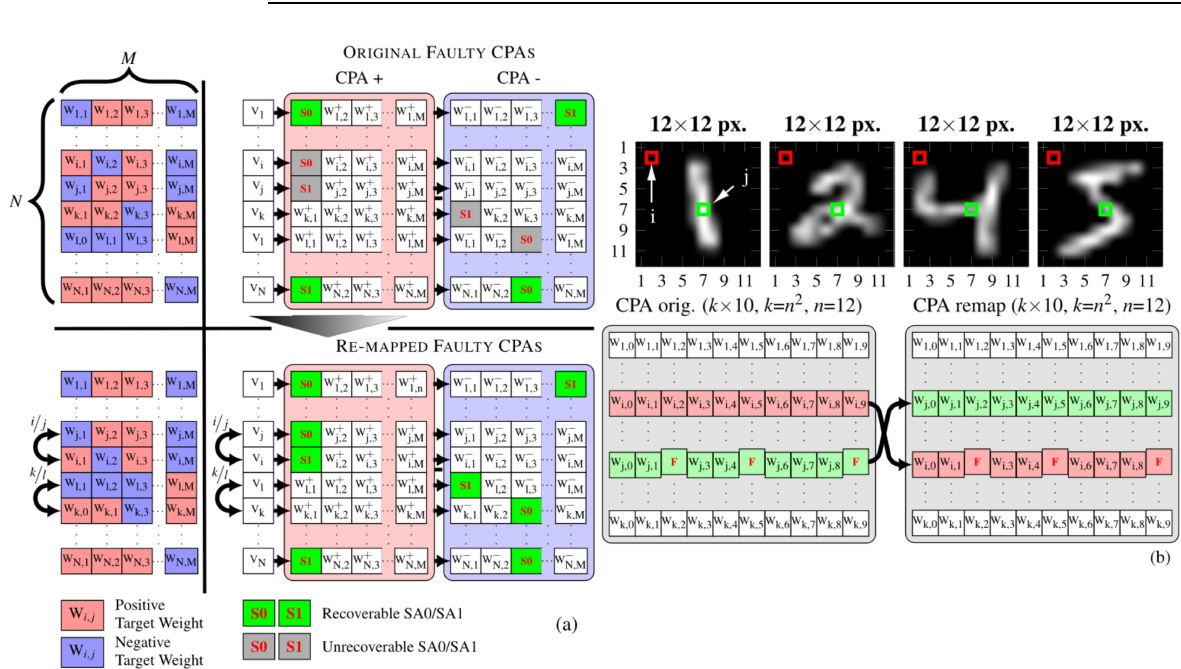
Figure 5. ( a ) Sketched representation of the fault-tolerant adaptative mapping process (Algorithm 1) depicting the conductance compensation (top) that allows the tolerance of faults in the first and last rows (green-shaded cells) but which is uncapable of handling other SAFs (unrecoverable faults, grey-shaded cells). A row permutation approach (bottom) is required to turn unrecoverable faults into recoverable faults (See Table 2). ( b ) Row permutation is also used for Algorithms 2 and 3. In the latter, it is employed to re-map the faultiest CPA rows to the inactive image pixels. The MNIST case is shown as an example.